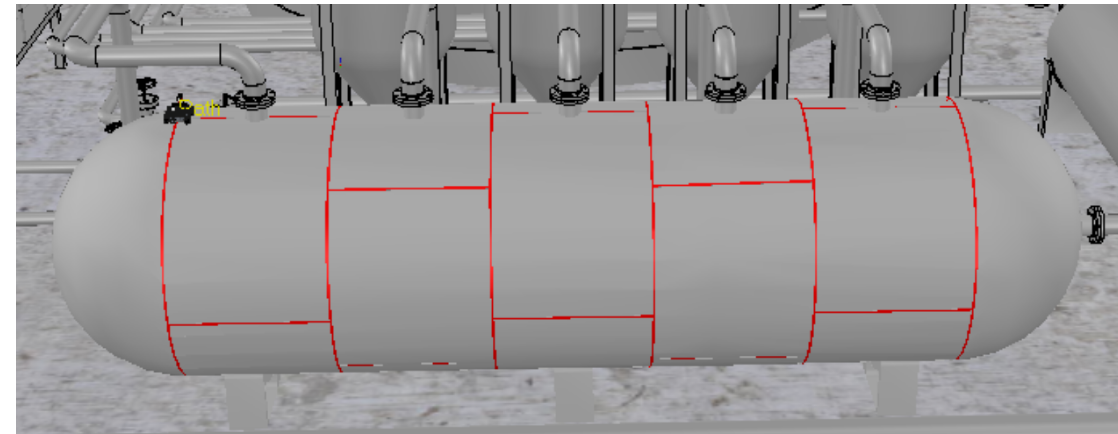
Figure 1. Storage tank in a refinery. The weld beads are highlighted in red.